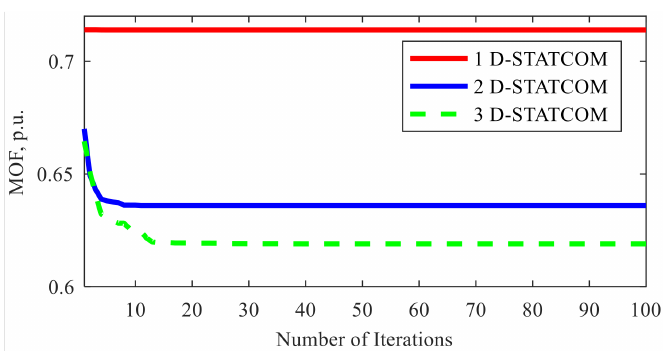
Figure 11. Convergence characteristics for OADS in 33-bus PDN.